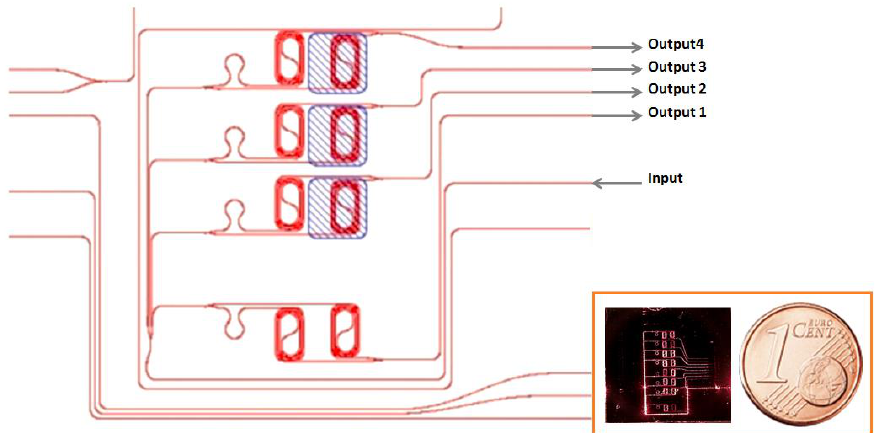
Figure 1. Sketch of the asymmetric Mach–Zehnder interferometer chips measured; ( inset ) photograph of the chip and a one euro-cent coin for comparison. The sensor here is an eight aMZI sensor.